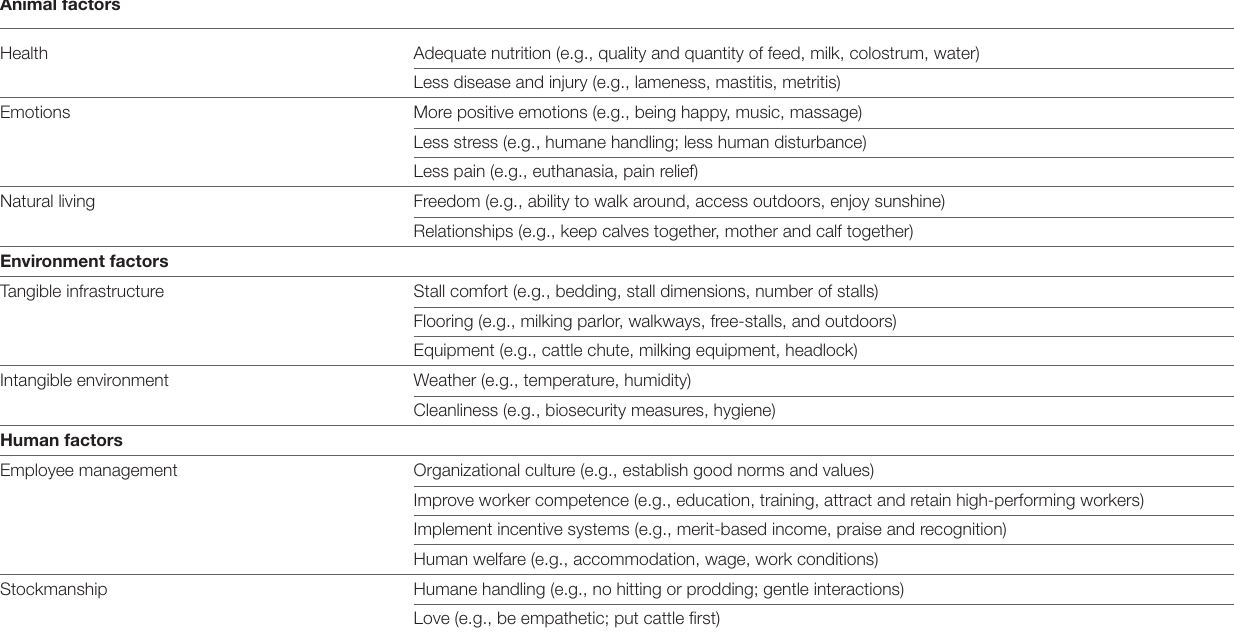
TABLE 1 | A compilation of workers’ responses to what is important to cattle, and what cattle like. Animal